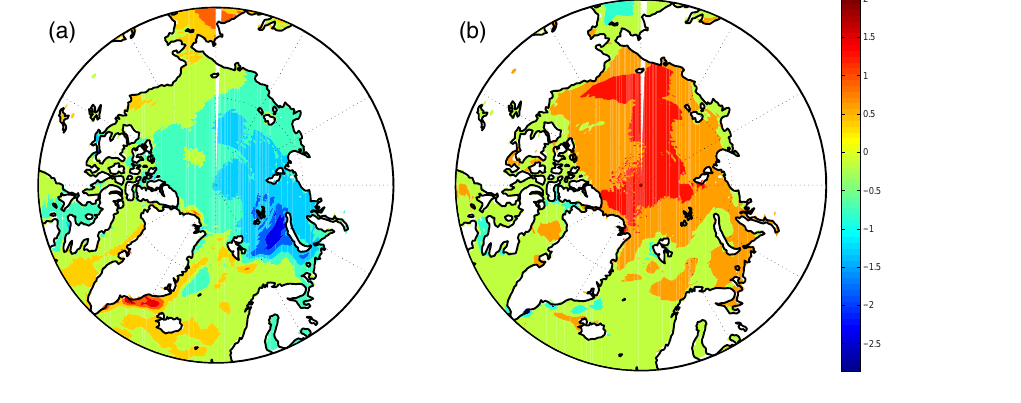
Figure 2. FMA (a) and ASO (b) spatial patterns (1st mode) of SDL. Table 1. Oscillation indices (OI) having correlation statistically significant at 95 % with seasonal SDL (left) and SIC (right) (only mode 1 is